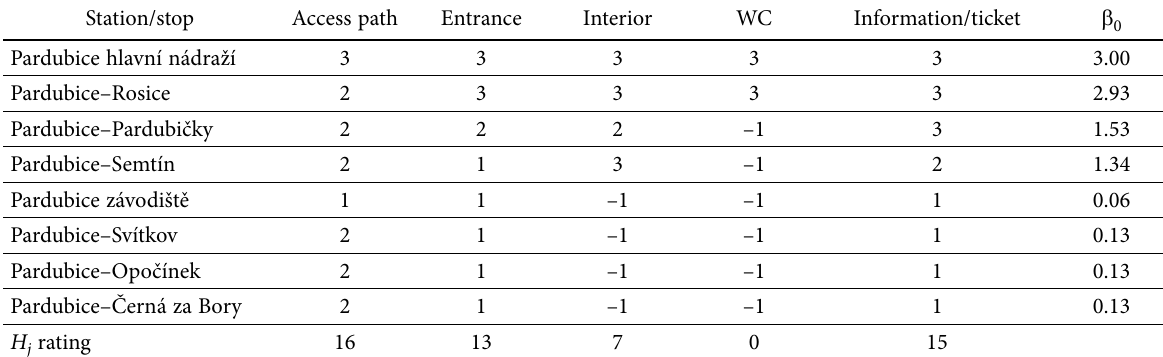
Table 1. Evaluation of railway stations and stops in Pardubice